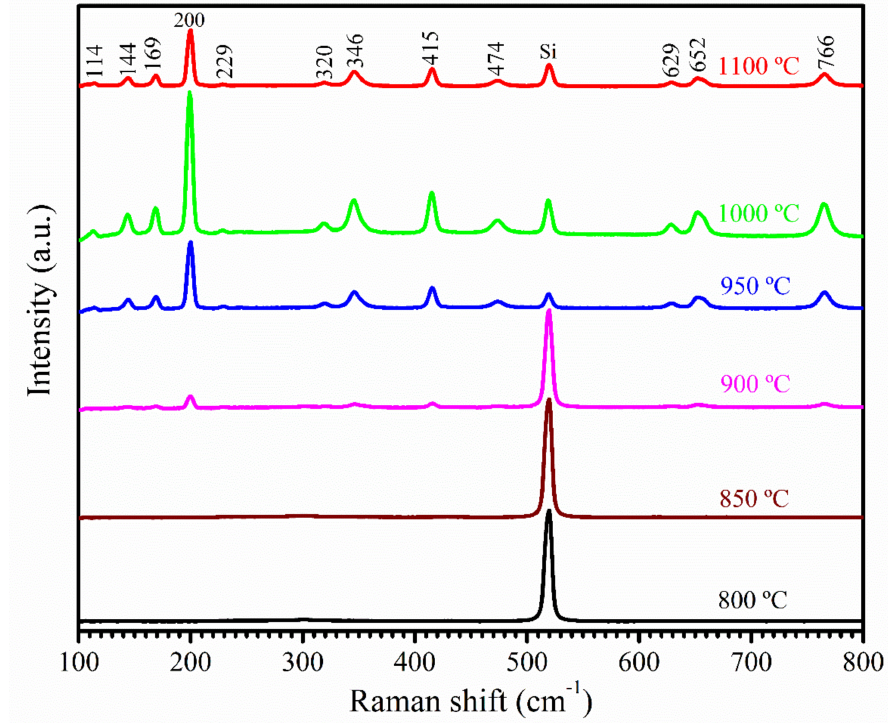
Figure 3. Room-temperature Raman spectra of β -Ga 2 O 3 NWs prepared at various temperatures from 800 to 1100 ◦ C for 32